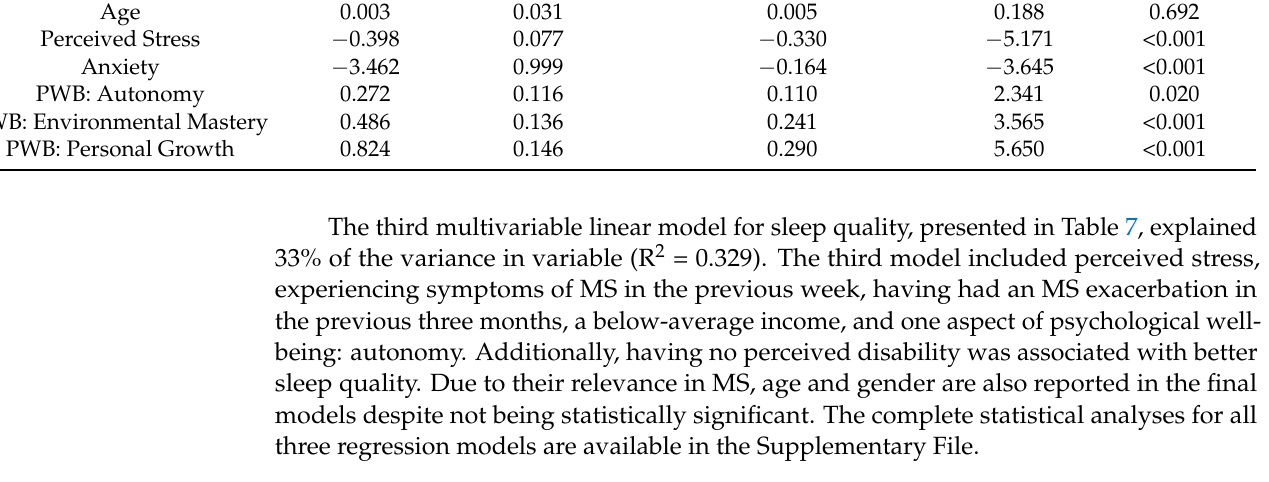
Table 7. Sleep Quality: a multivariable linear